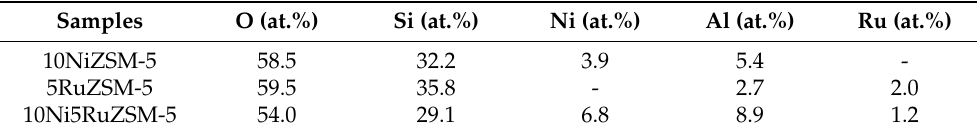
Table 3. Surface chemical composition of the parent catalysts. Samples